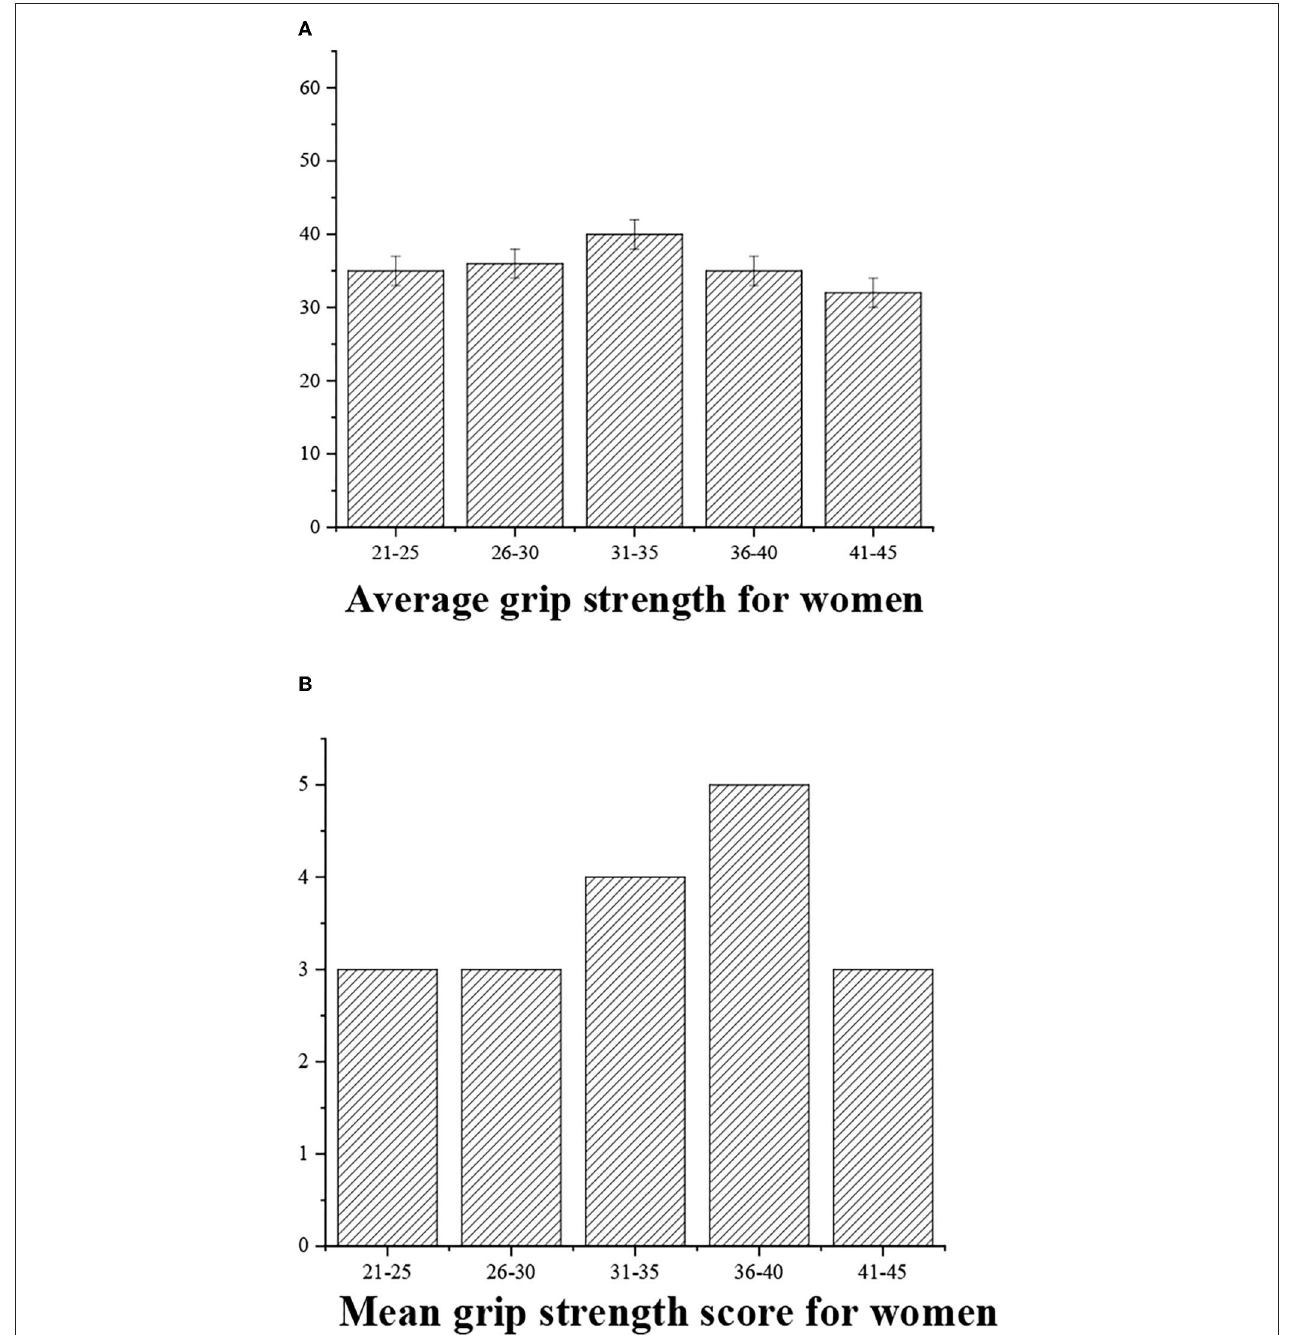
FIGURE 7 | (A) Statistical average grip strength for women of different ages. (B) Grip strength